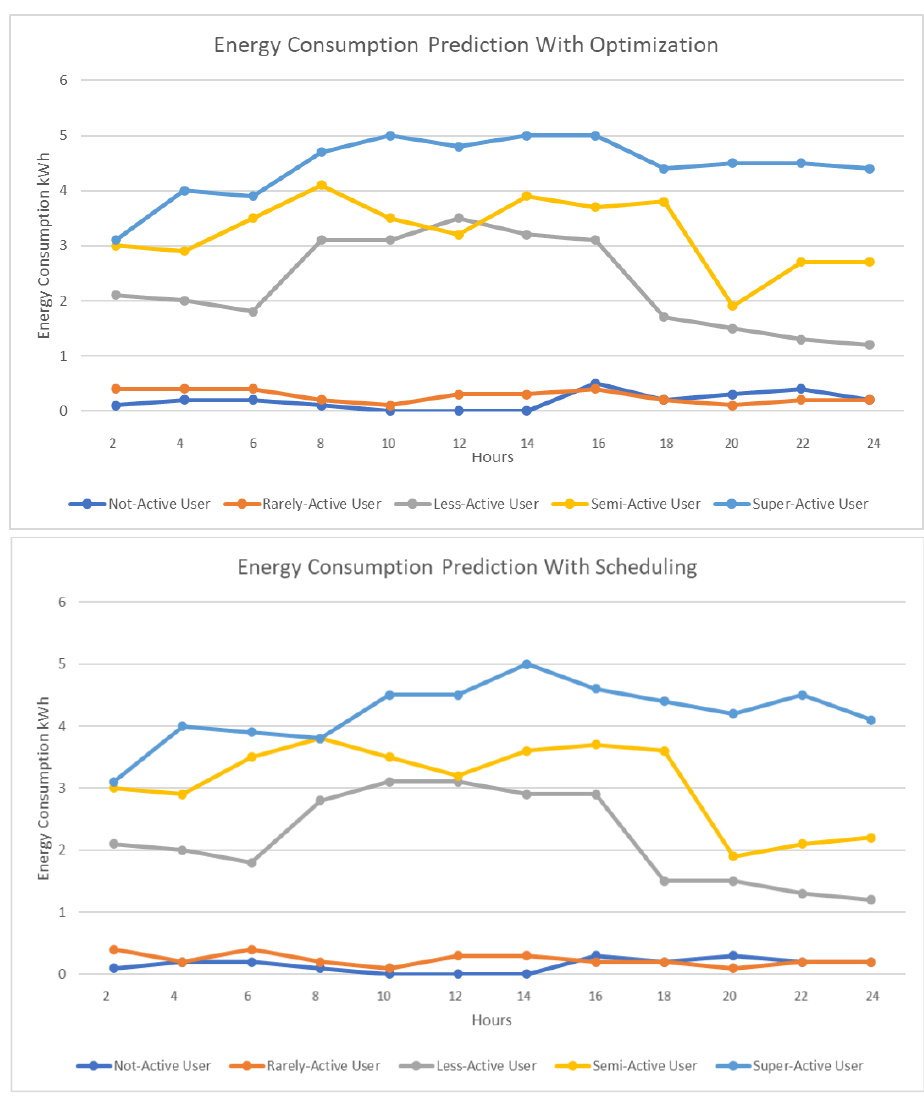
Figure 9. Energy consumption with